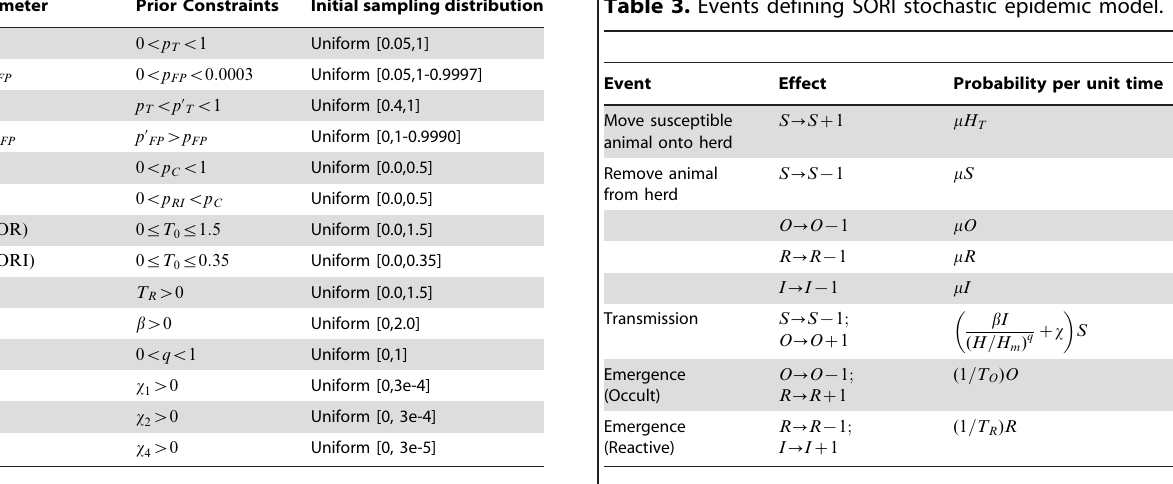
Table 3. Events defining SORI stochastic epidemic